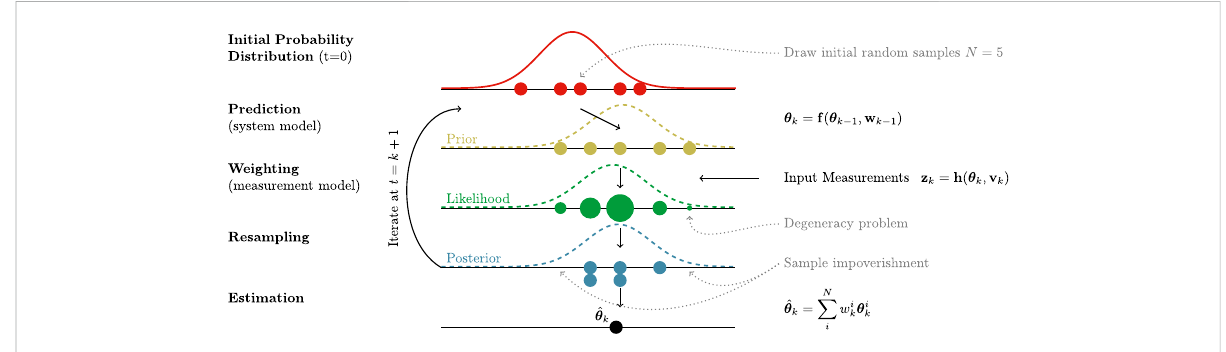
FIGURE 1 Simple scheme of the routine of a SIR PF architecture implementing Bayesian state space estimation. In each stage, particles (depicted with circles)arerepresentedwithadifferentcolor.Thecorrespondingnameofthestageisontheleftside,whiletherightsideisdevotedtopresentsome important equations governing the system and highlighting the main issues that PF face. The radius of particles is proportional to their